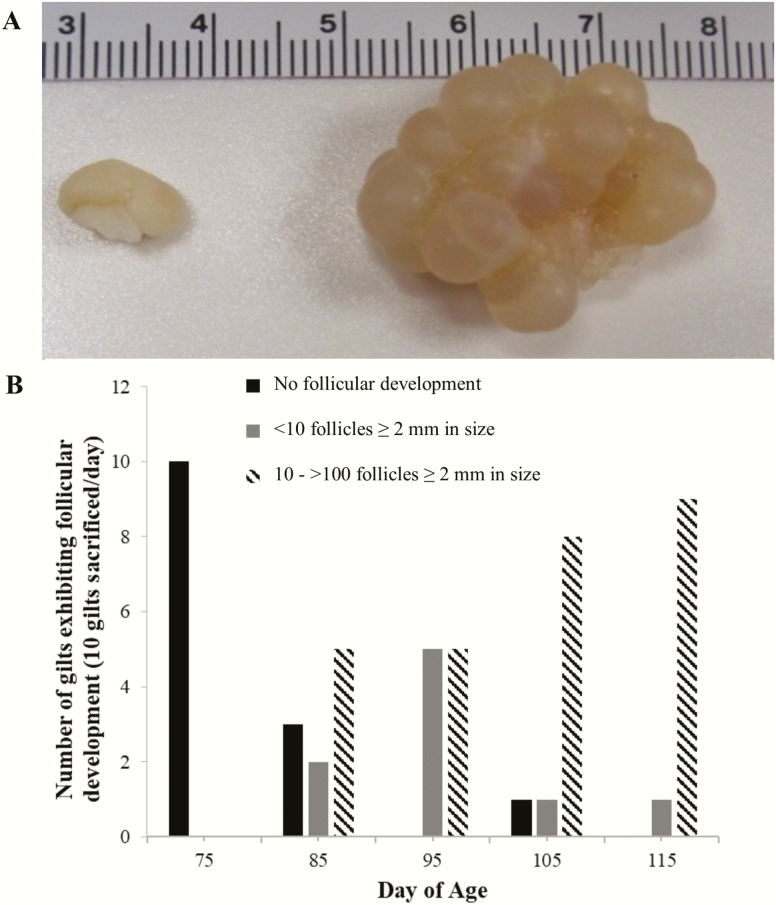
Representative image showing distinct variation in ovarian tertiary follicular development. (A) Ovaries collected from gilts of similar age (98 ± 4 d of age). Left—undeveloped ovary; right—ovary containing tertiary follicles. (B) Variation in follicular development in gilts exists between postnatal days 75, 85, 95, 105, and 115. As gilts progressed in age, follicular development increased. On postnatal day 75, all ovaries lacked tertiary follicles. Variation in tertiary follicular development was greatest between postnatal days 85 and 95. By postnatal day 115, all gilts had some form of follicular development with the majority of ovaries having tertiary follicles. The black bars represent the number of gilts lacking tertiary follicle development. Gray bars represent the number of gilts having a total of 1 to 10 tertiary follicles ≥ 2 mm in diameter. Striped bars represent the number of gilts having a total of 10 to greater than 100 tertiary follicles ≥ 2 mm in diameter.